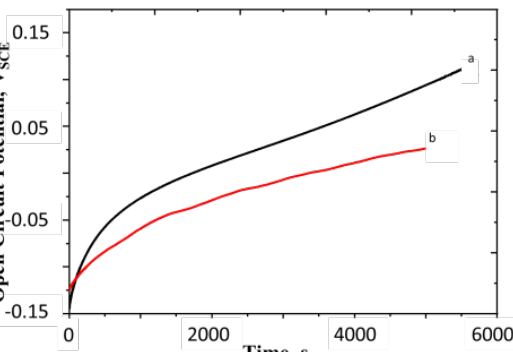
Figure 5. Open circuit potential of polyaniline with and without nitrogen bubbling ( a ) OCP curve with surface aeration; ( b ) OCP curve with nitrogen bubbling through the solution. Concentration of H 2 SO 4 = 0.5 M, surface mass density of the film = 16.3 g m −2 , temperature = 25 °C. All potentials are reported with respect to SCE.